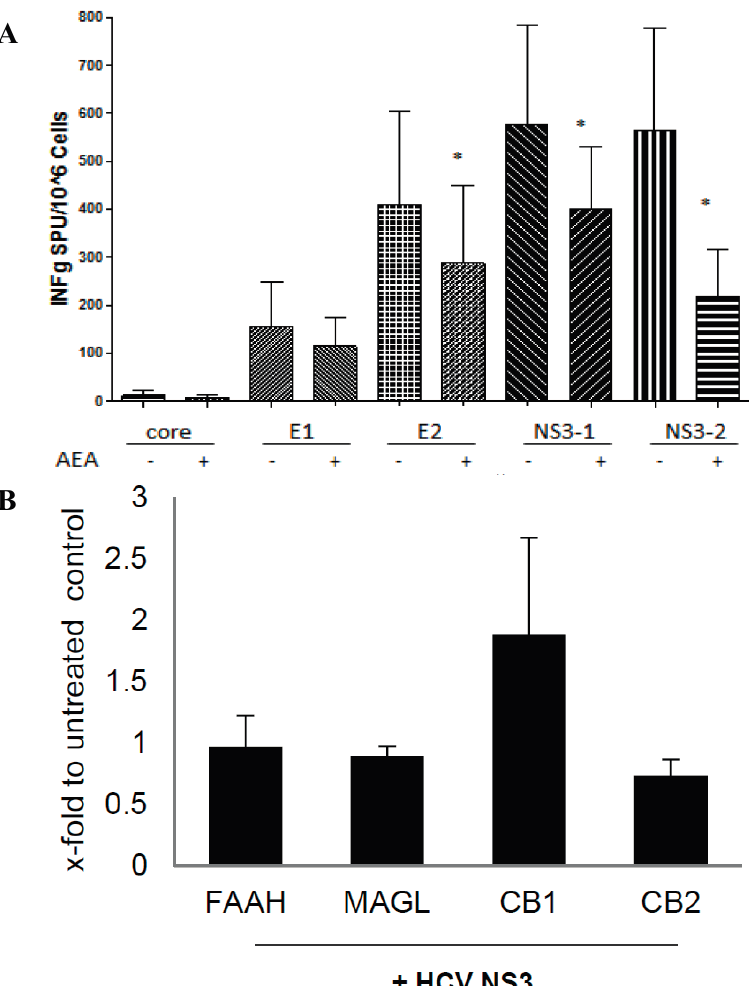
Figure 5. AEA suppresses HCV-induced IFN- γ release in PBMC. ( A ) IFN- γ production in PBMC ( n = 6) by HCV peptide pools (5 µg/mL) and 2.5 µM AEA. Results are expressed as spot-forming cells (SFC) per 1 × 10 6 cells; ( B ) FAAH, MAGL, CB1 and CB2 mRNA in PBMC by the NS3 HCV pool. * p < 0.05 vs. corresponding non-treated